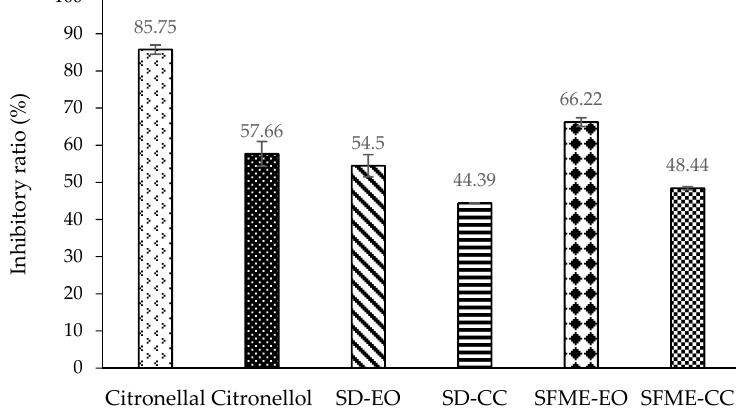
Figure 4. β -Carotene/linoleic acid inhibitory ratio (%) of ‘Mato Peiyu’ leaf essential oils, citronellal, and citronellol. SD-EO, SFME-EO, citronellal, and citronellol were measured at a concentration of 0.150% ( v / v ). SD-CC and SFME-CC were measured at concentrations of 0.076% and 0.090% ( v / v ) according to the composition ratios in 0.150% ( v / v ) SD-EO and SFME-EO, respectively. Data are presented as the mean ± standard deviation based on triplicate determination.